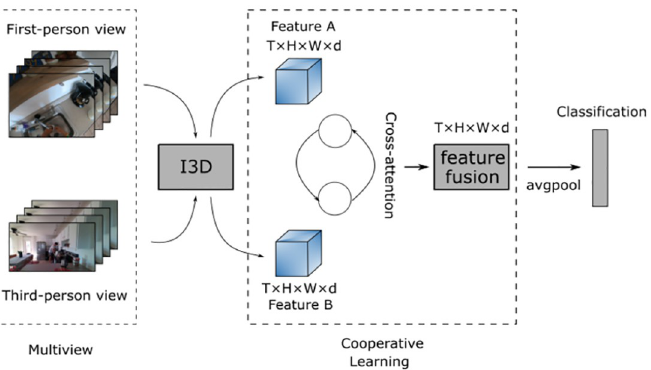
Fig 2. Overview of our model. Given the corresponding multiple views of RGB frames, we use I3D [43, 44] to compute features for each view, where different information about the action may exist for different views. These features are provided to cross attention as input and then classified after feature